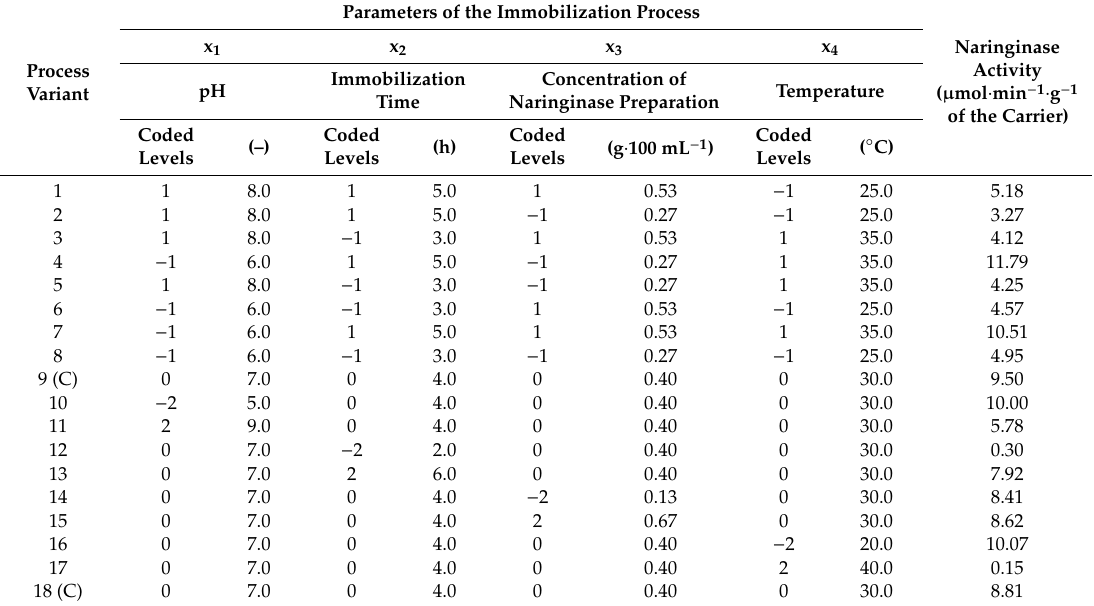
Table 2. Results of an experiment performed in accordance with Box-Wilson’s central composition plan to determine the e ff ect of immobilization parameters on the activity of immobilized naringinase.